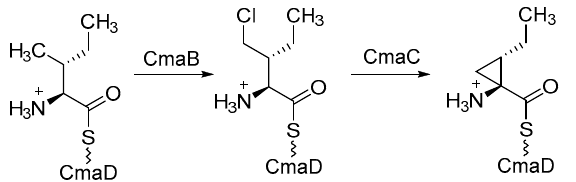
Figure 17. Schematically example for formation of cyclopropane initiated by CmaB through